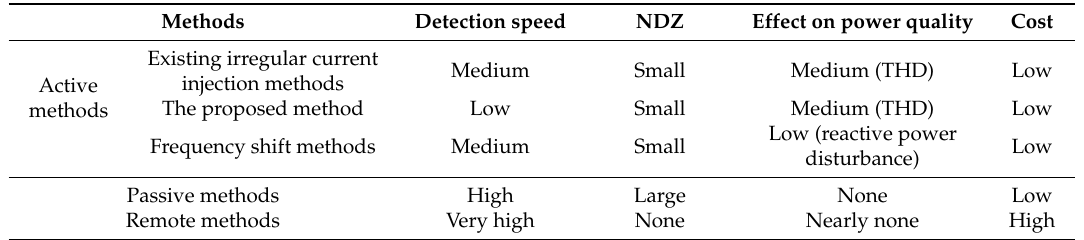
Table 3. Comparison of the mentioned island detection methods: non-detection zone (NDZ); total harmonic distortion